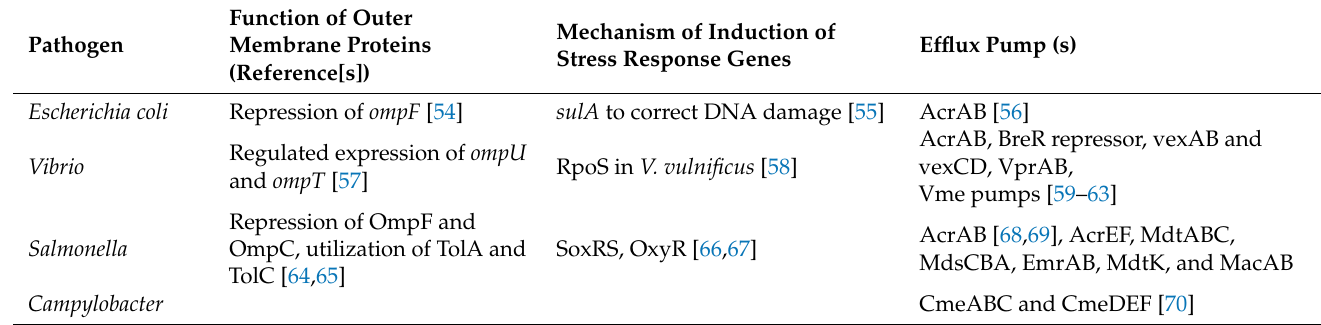
Table 2. Some bile resistance mechanisms in Gram-negative enteric pathogens. The table was constructed using data from Sistrunk and colleagues in 2016